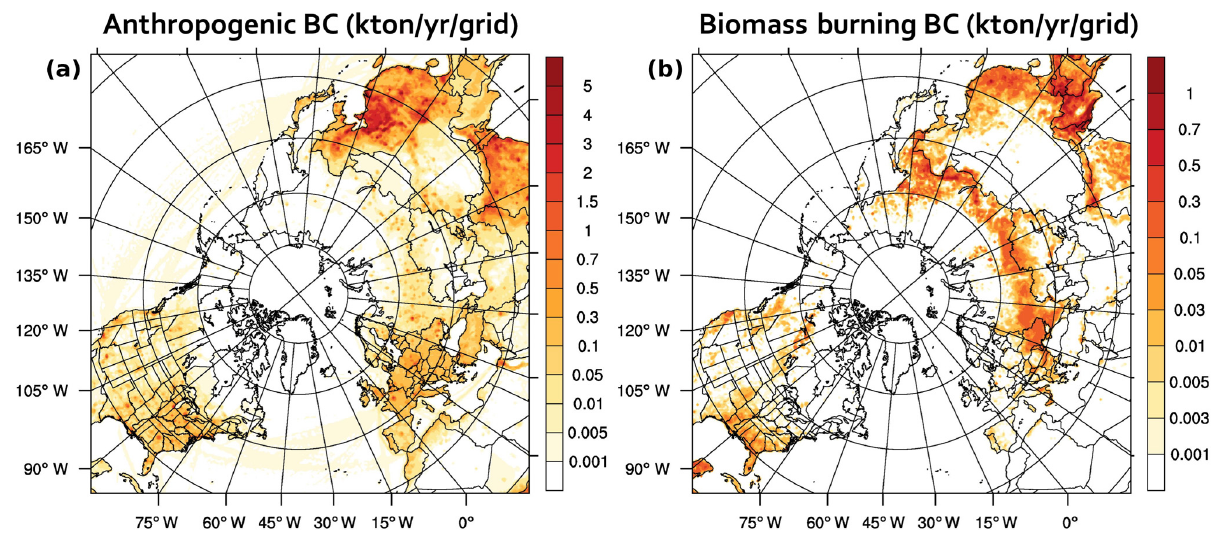
Figure 1. Spatial distribution of anthropogenic BC emissions (a) and wildfire BC emissions (b) in Ggyr − 1 grid − 1 . This figure is generated using NCAR Command Language (NCL) version 6.3.0, open-source software free to the public, by UCAR/NCAR/CISL/TDD, http://dx.doi. org/10.5065/D6WD3XH5 (last access: 13 November